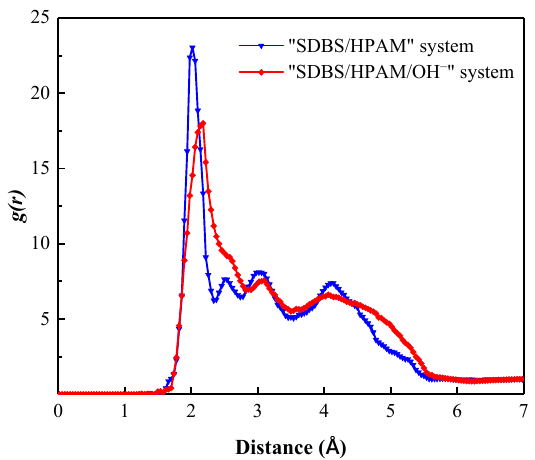
Figure 13. Radial distribution functions of -COO − of HPAM molecules and surrounding cations in different foam